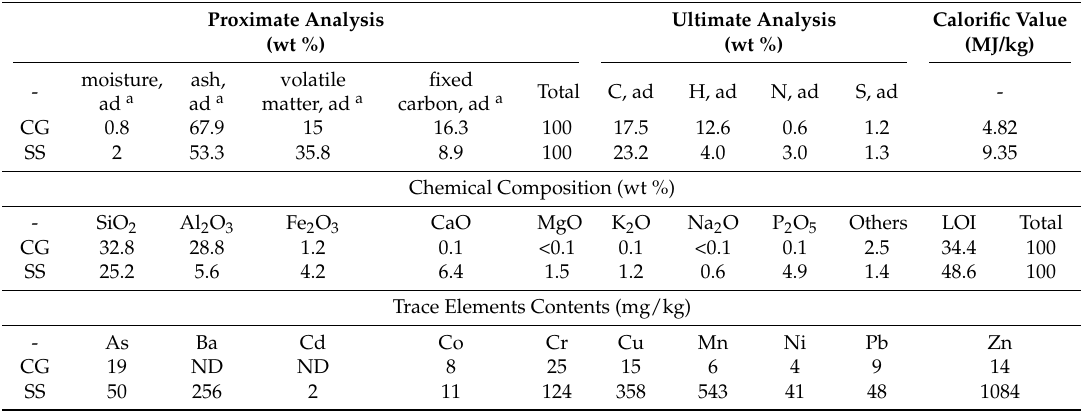
Table 1. Chemical compositions of coal gangue and sewage